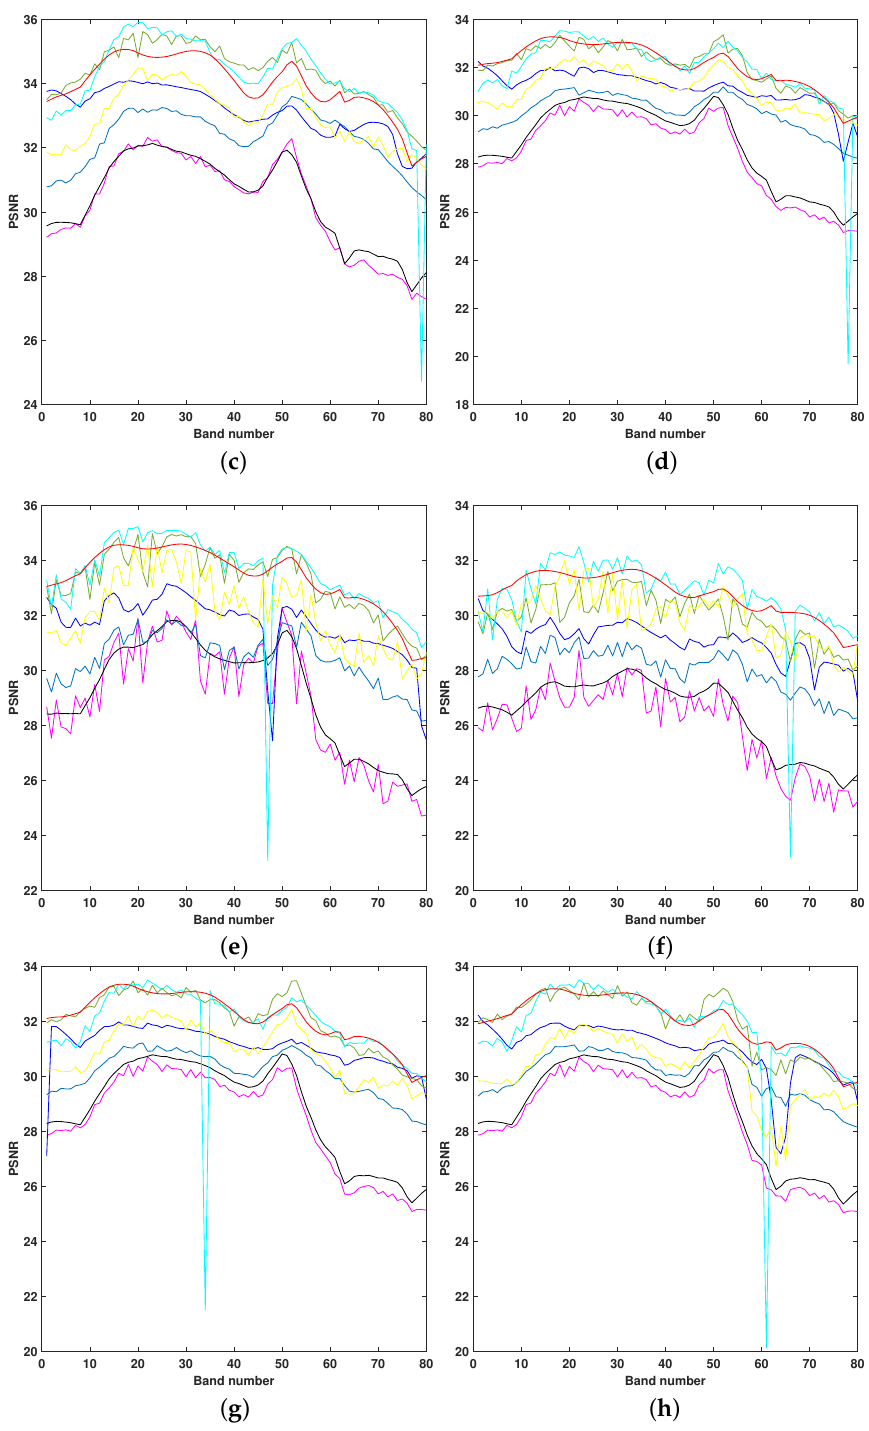
Figure 5. The PSNR values of each band in dataset-1 after denoising by eight different methods under ( a ) case 1, ( b ) case 2, ( c ) case 3, ( d ) case 4, ( e ) case 5, ( f ) case 6, ( g ) case 7, ( h ) case